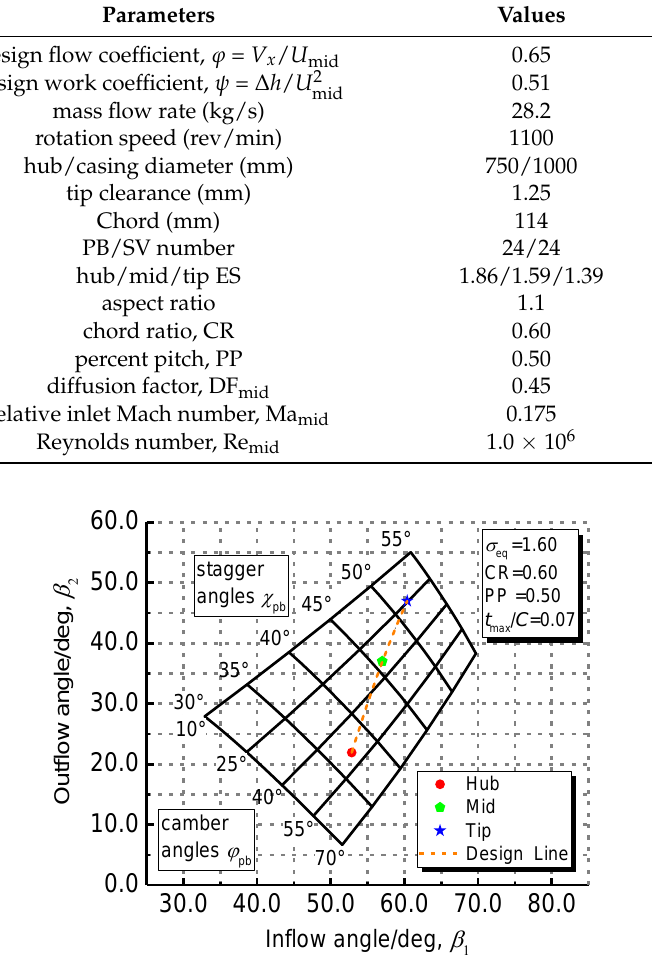
Figure 19. Reference minimum-loss inflow and outflow angles with camber angles and stagger angles as functions according to the 2D correlations.